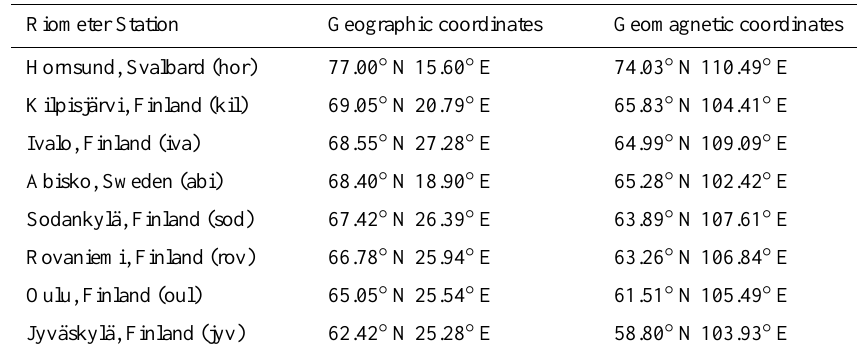
Table 2. Geographic coordinates and corrected geomagnetic (CGM) coordinates of riometer stations at altitude of 90km for spike event Fig.